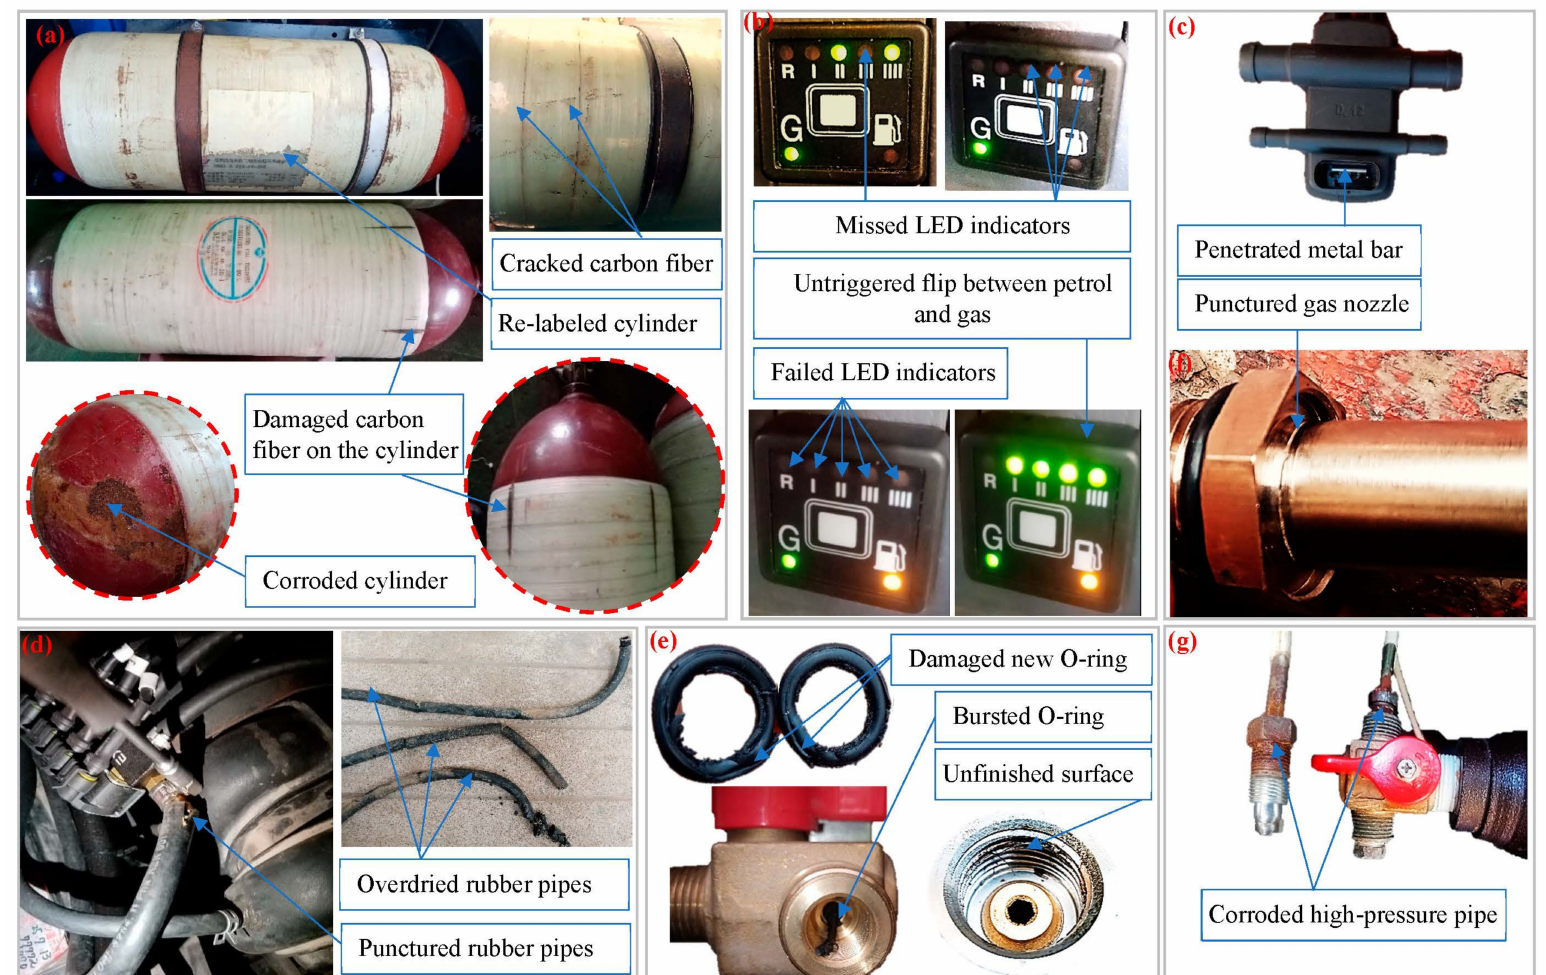
Figure 8. Some of the technical challenges found in the NGVs ( a ) defective CNG cylinders, ( b ) malfunctioning of changeover switches, ( c ) malfunctioning MAP sensor, ( d ) punctured hose pipes, ( e ) damaged O–rings, ( f ) cracking of CNG injection nozzles, and ( g ) corroded high–pressure